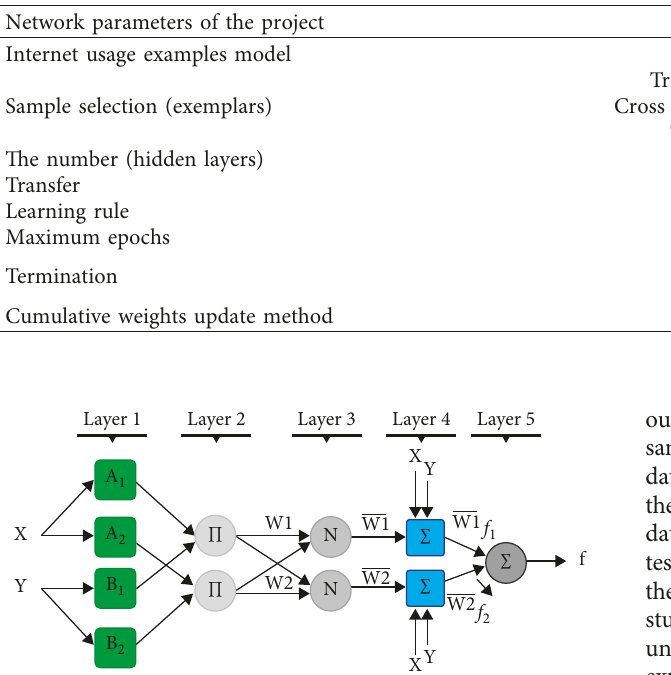
Table 1: Network model parameter setting.